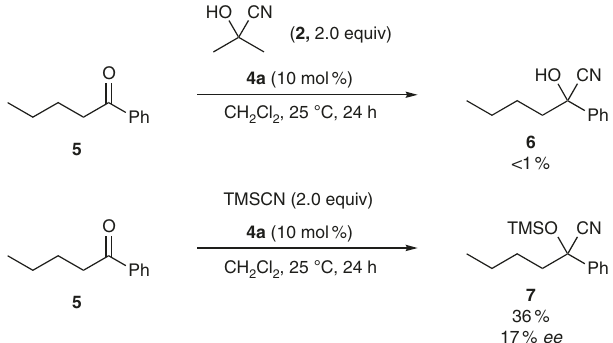
Fig. 4 Cyanohydrin formation under the optimized conditions.